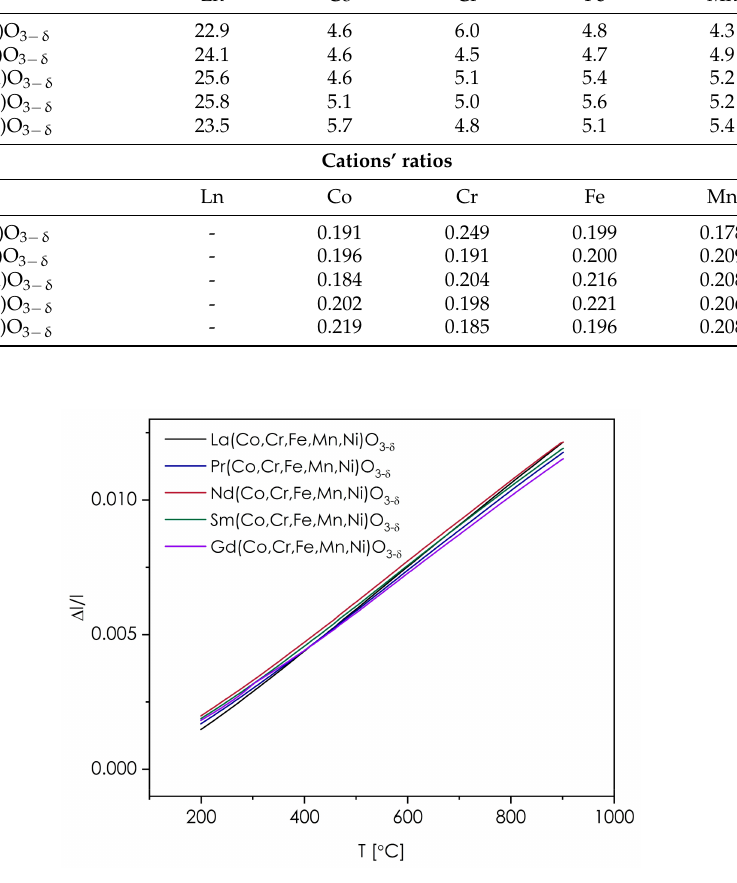
Figure 4. Results of the dilatometric measurements of the Ln(Co,Cr,Fe,Mn,Ni)O 3 − δ sinters (heating run). Table 3. Thermal expansion coefficient of Ln(Co,Cr,Fe,Mn,Ni)O 3 − δ series (heating run) evaluated in 200–900 ◦ C